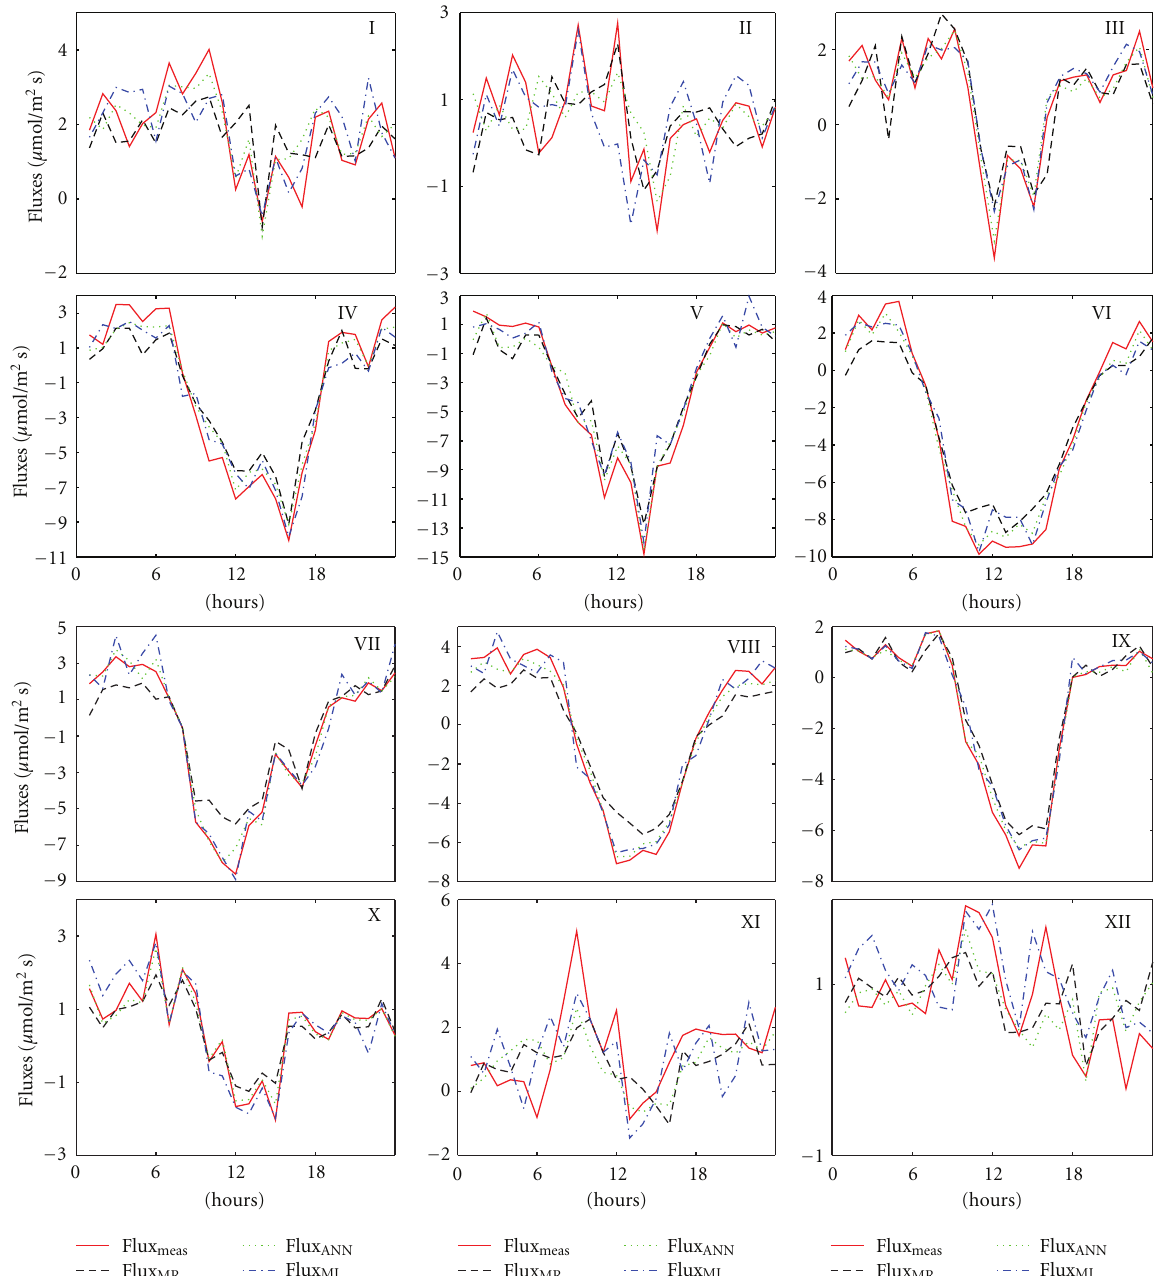
Figure 1: Diurnal variation of the four fluxes for each month, represented as follows: measured flux: red, continuous line; MR filled: black, dash line; ANN filled: green, dotted line; MI filled: blue, dash line. The month is identified by corresponding roman numerals in the right corner of each